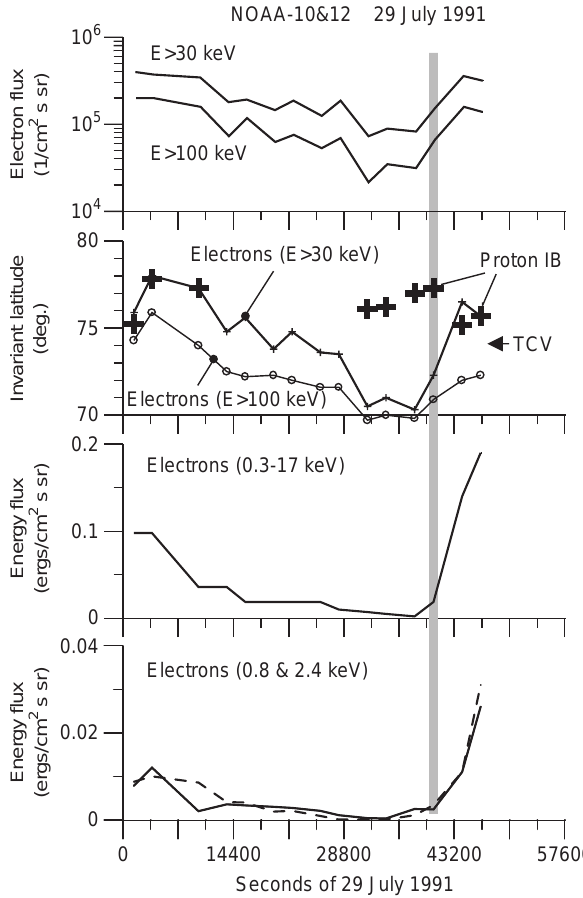
Fig. 5. The four panels in this figure present an overview of the NOAA 10 and 12 satellites particle data for the first 16 h (00–16 UT) of July 29, 1991, orbit by orbit. The maximum electron flux of each dayside north polar pass is displayed in the top panel for the two energy bins used in this study. The second panel exhibits the latitudes of the various boundaries as determined for each pass. Crosses mark the proton IB. The line and the line with open circles , respectively, mark the trapping boundaries of the > 30 keV and > 100 keV electrons. The latitude of the TCV is also marked in this panel and the vertical bar through all panels marks the time of the TCV event. The directional energy flux of low energy electrons displayed in the bottom two panels are in units of ergs/cm 2 s ster. Further explanation is given in